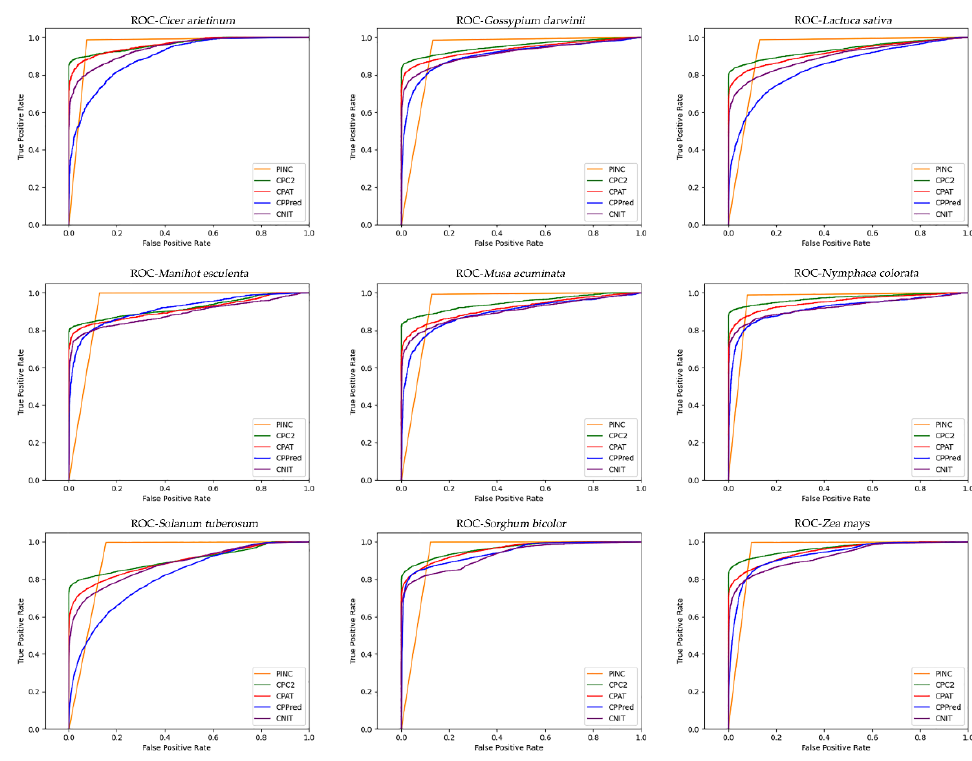
Figure 5 . ROC curves for 5 tools on 9 plants.